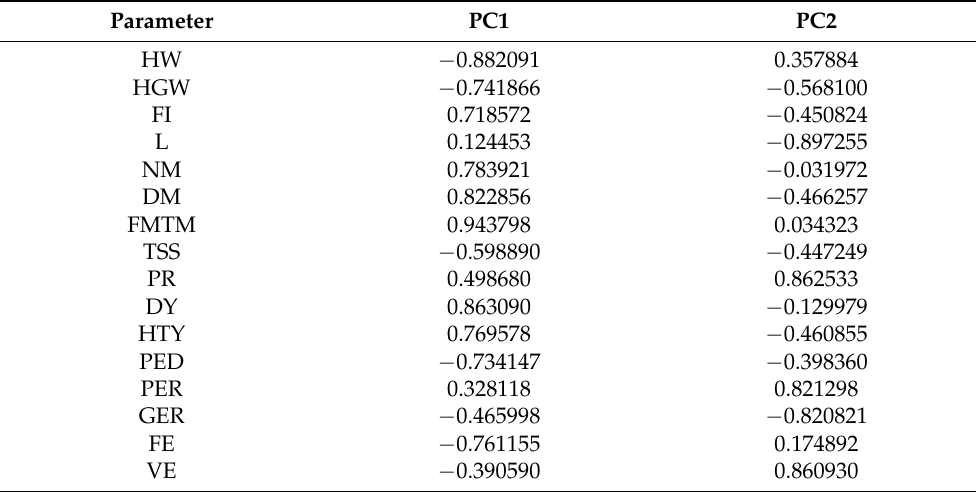
Table 6. Factor coordinates of the physicochemical parameters, based on correlations.